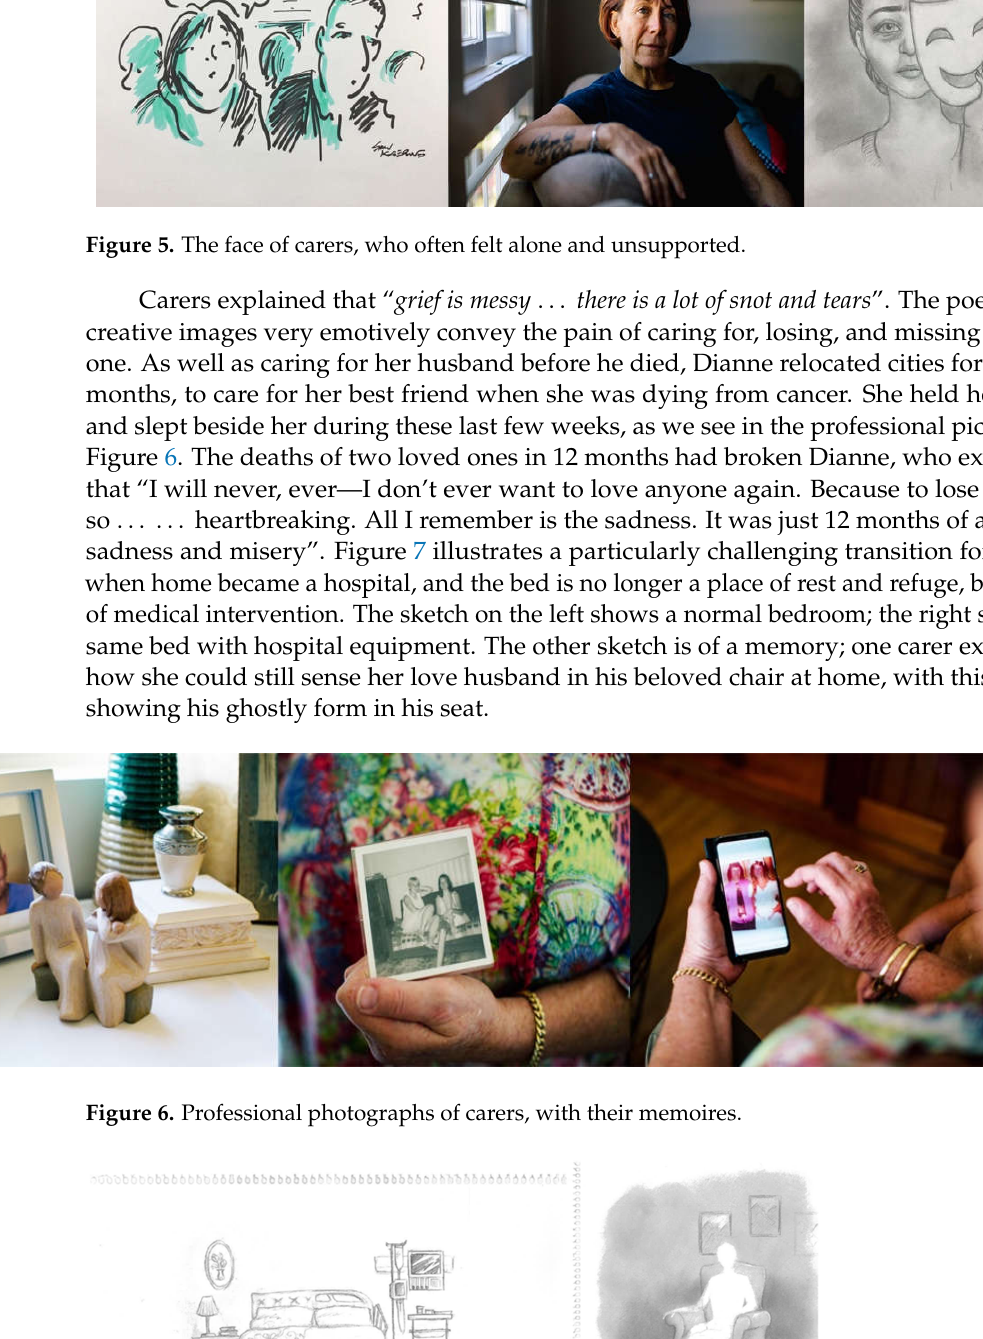
Figure 7. Sketches—when home became a hospital, and the memory of loss.